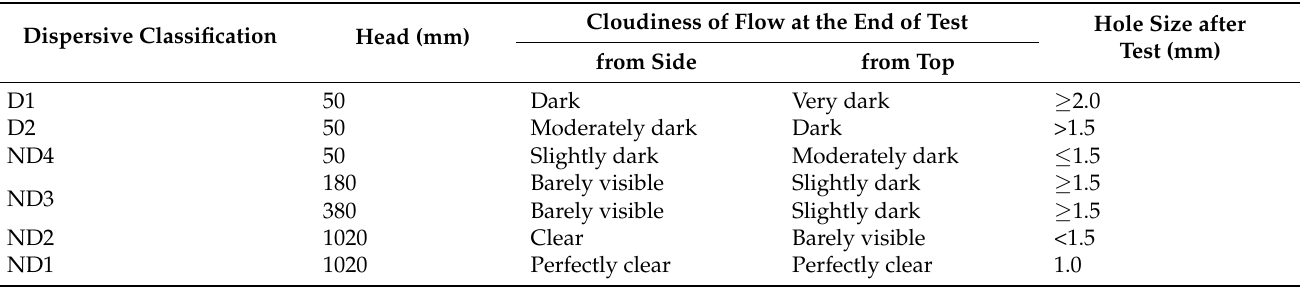
Table 3. The self-healing classification based on the pinhole test